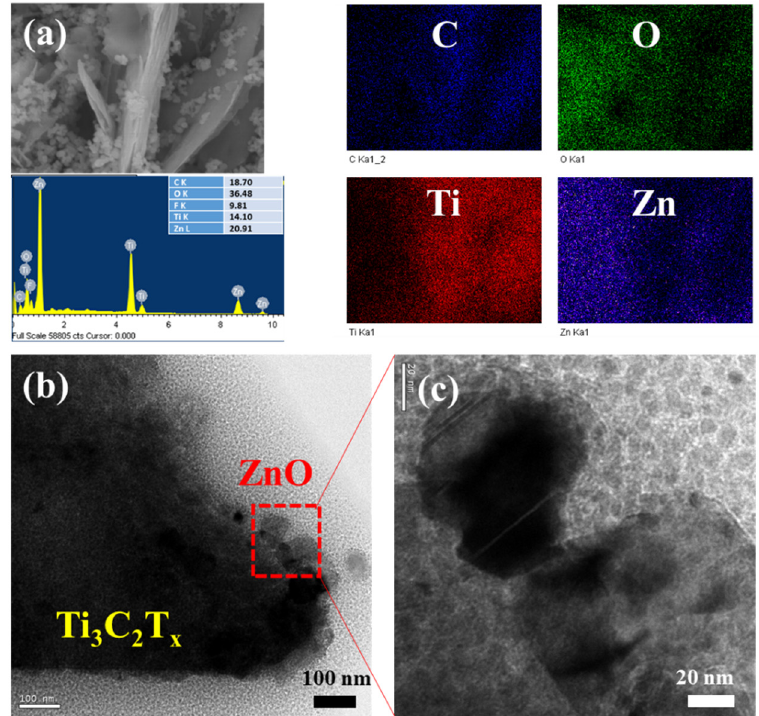
Figure 3. ( a ) SEM images and EDX spectrum with EDX element maps of Ti, C, O, Zn, and ( b , c ) HR- TEM images of ZnO/Ti 3 C 2 T x heterostructure.